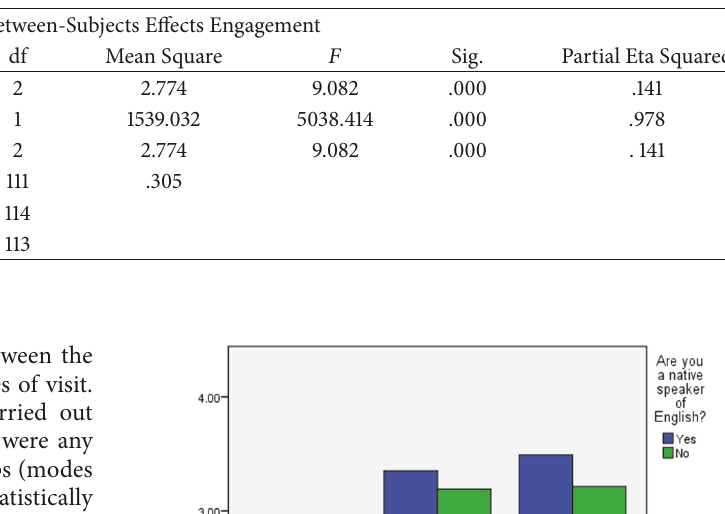
Table 4: Statistical significance of one-way ANOVA (engagement).